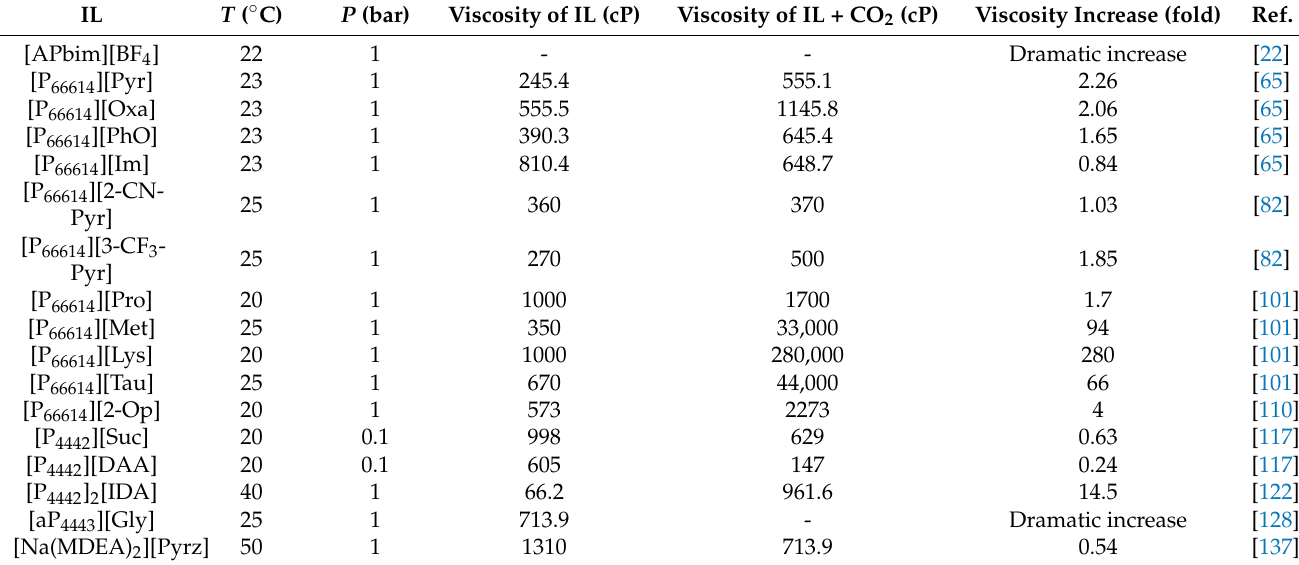
Table 5. The viscosities of typical functionalized ILs before and after CO 2